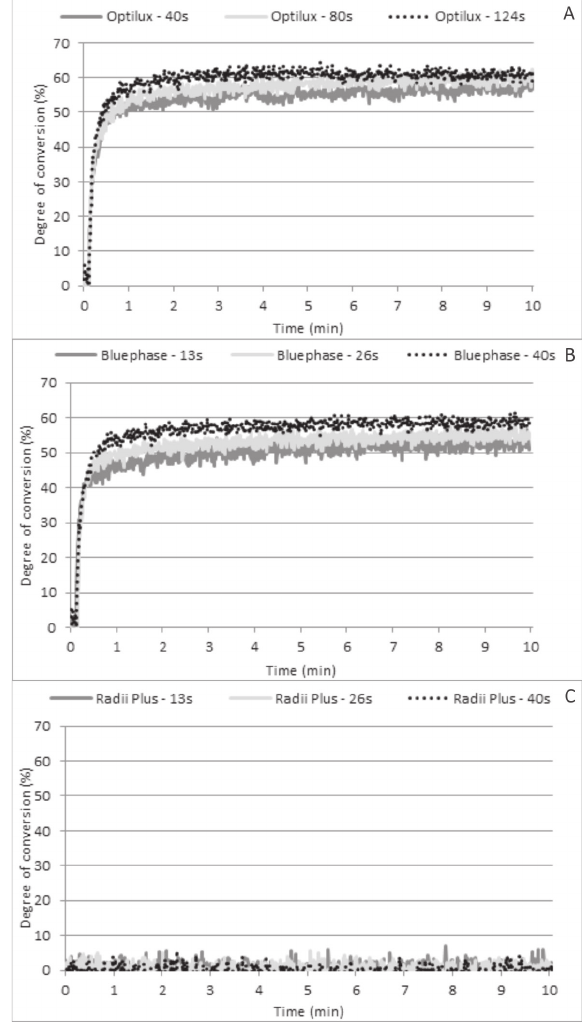
Figure 2- Time-based conversion of 2 mm thick RC layers exposed to Optilux 501 (A), Bluephase G2 (B), and Radii Plus (C) at varying RE